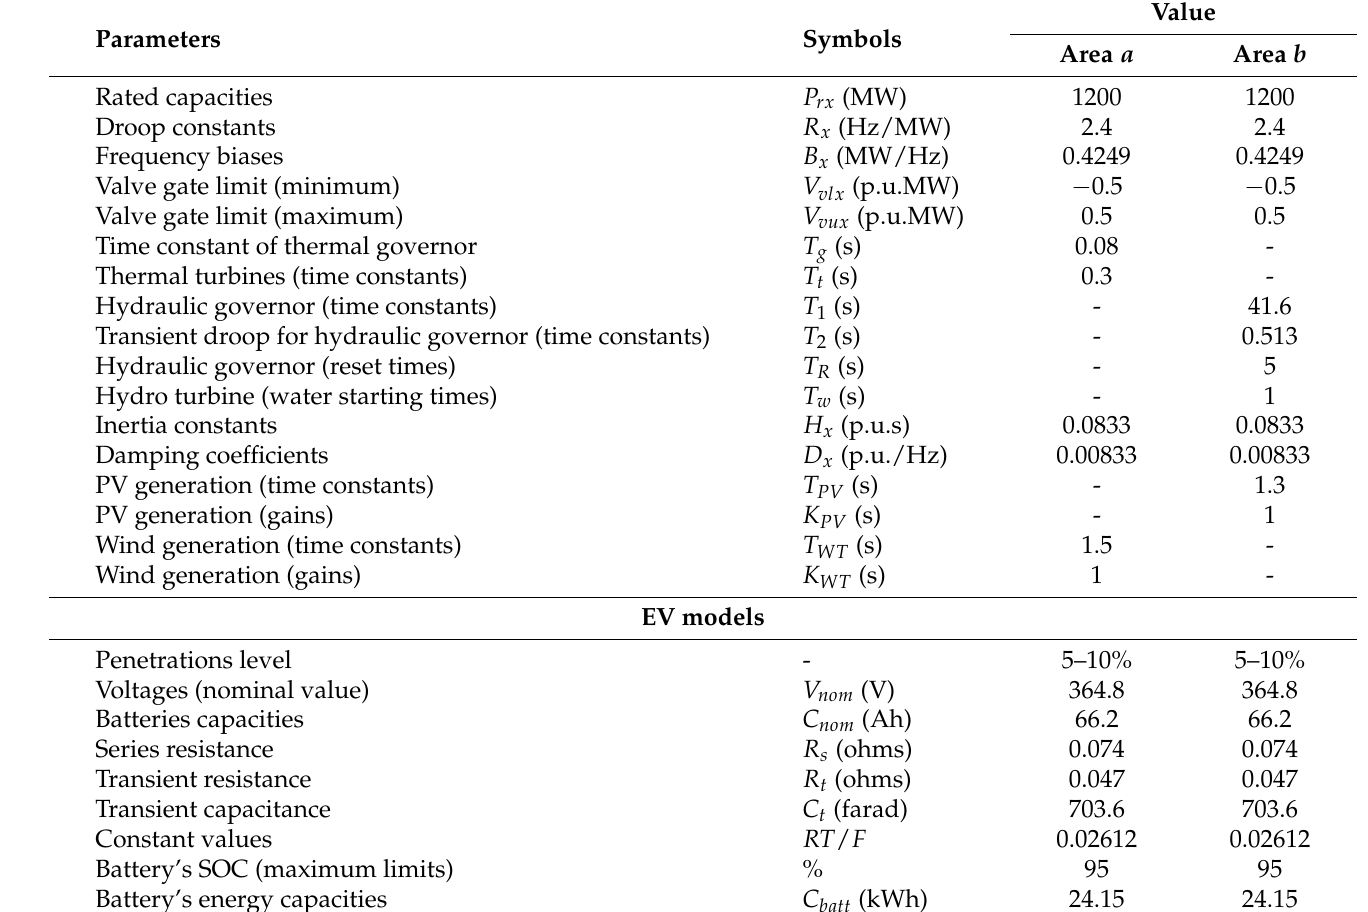
Figure 1. Construction of proposed controller and case study. Table 1. Parameters of the modeled grid ( x ∈ { a , b } ),